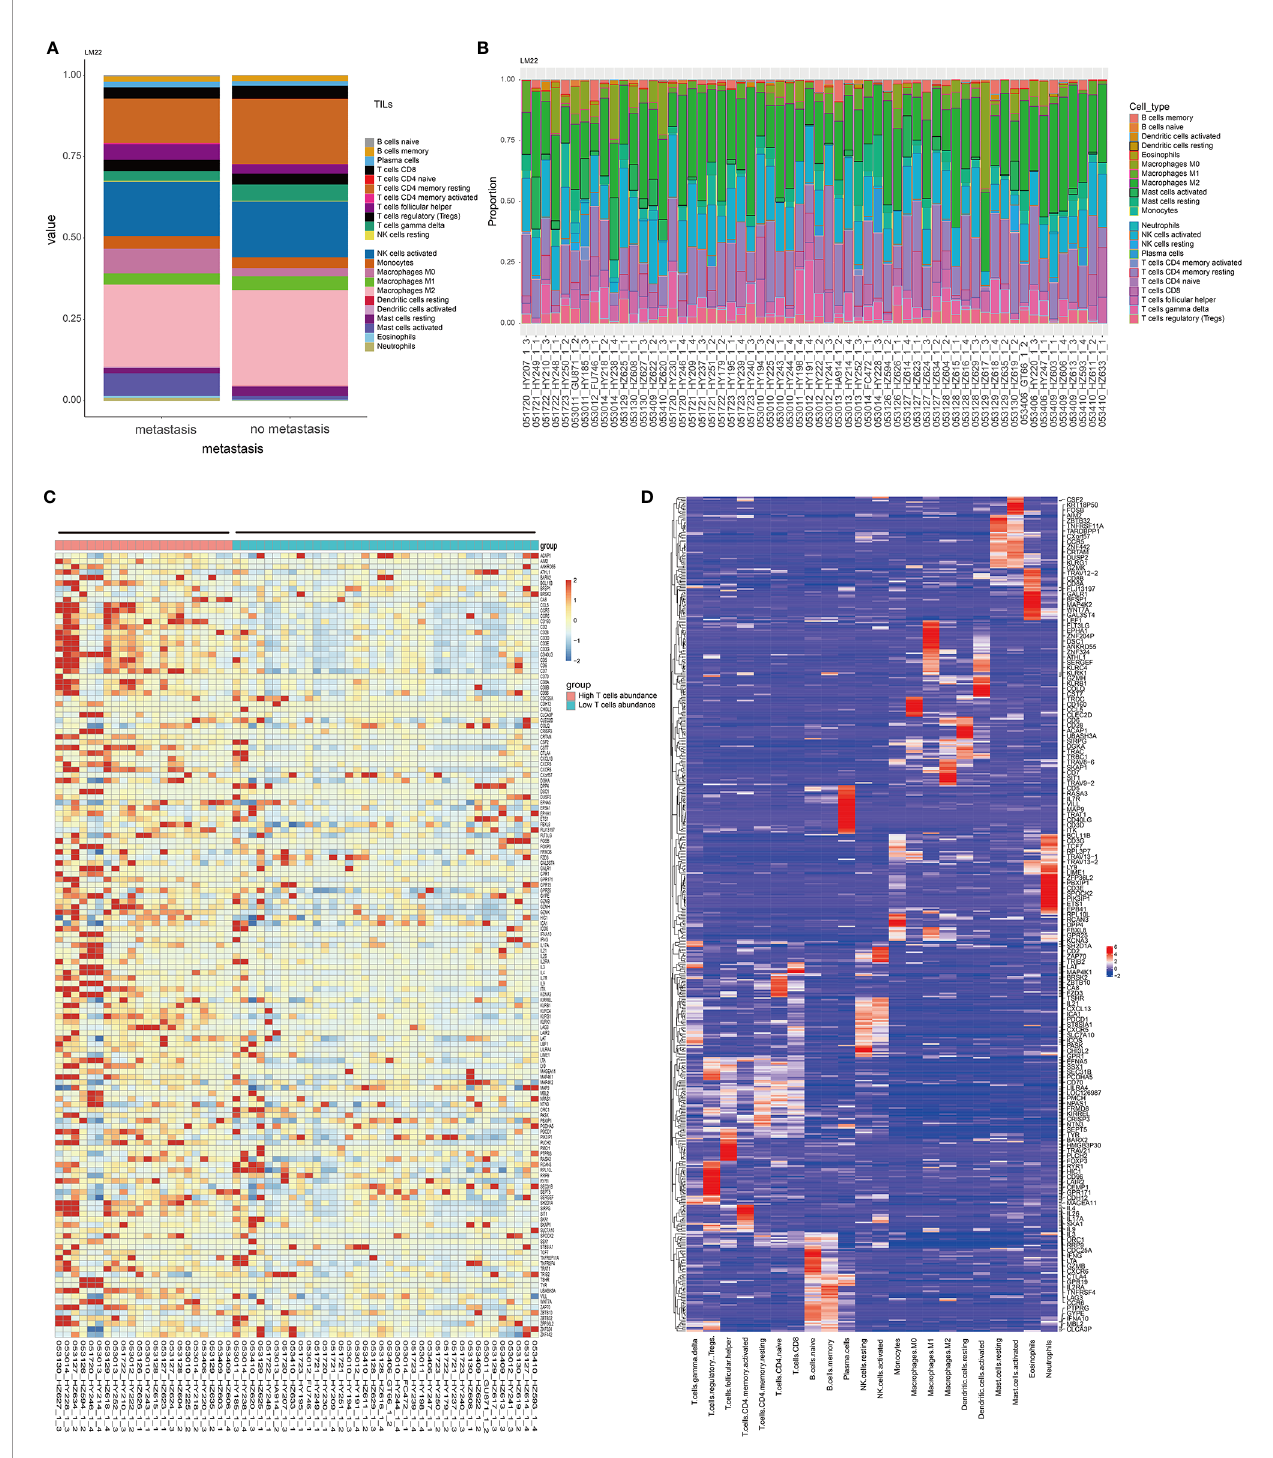
FIGURE 1 | Characteristics of immune in fi ltration in metastatic and non-metastatic GIST. (A) CIBERSORT algorithm was used to calculate the difference of the in fi ltration ratio of 22 immune cells between the metastasis group and non-metastasis group. (B) The characteristics of immunocyte in fi ltration in 60 patients were analyzed. (C) Thermogram of characteristic gene expression in T cells. (D) Thermogram of 22 characteristic genes of immune cells. The T cell-related characteristic gene set was